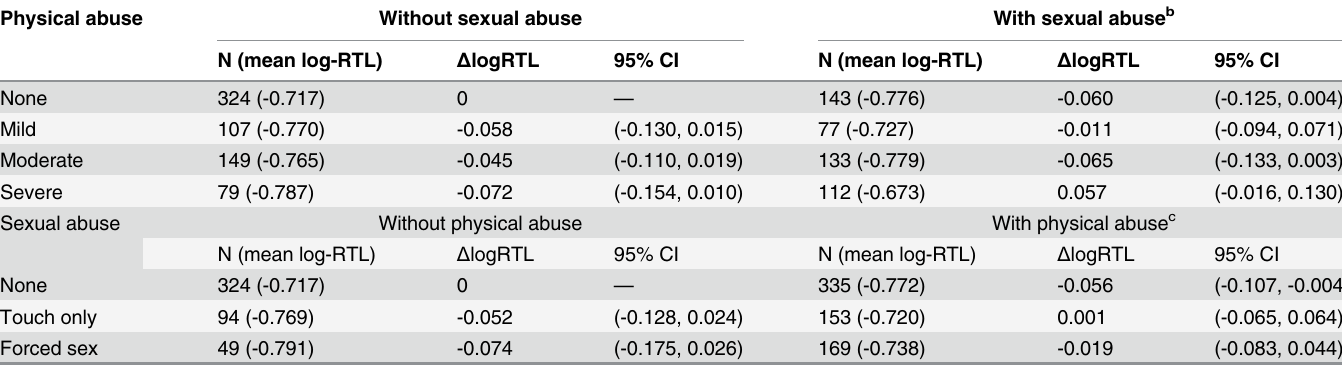
Table 4. Estimated difference in relative telomere length (RTL) by combinations of physical and sexual abuse in childhood.